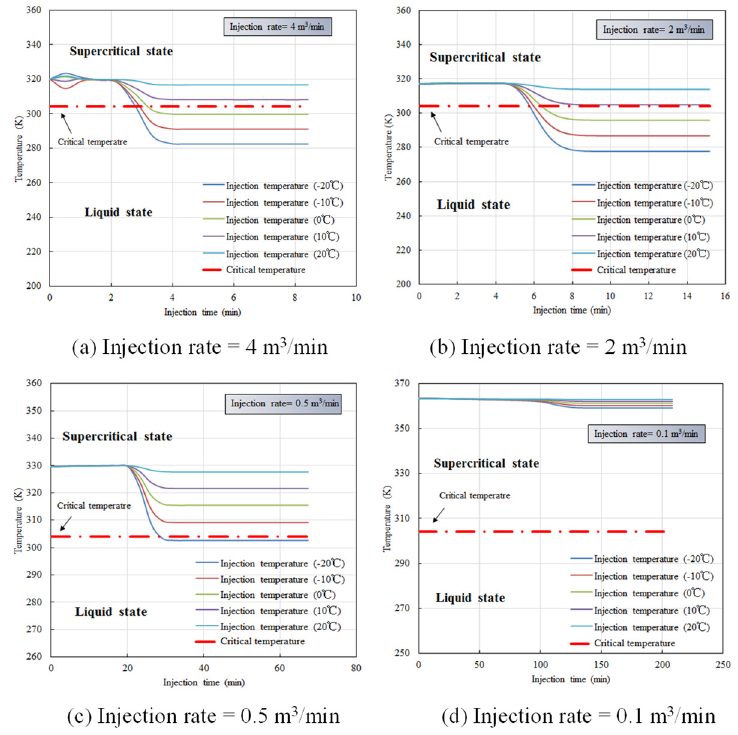
Figure 6. Relationship between well bottom temperature and injection time.